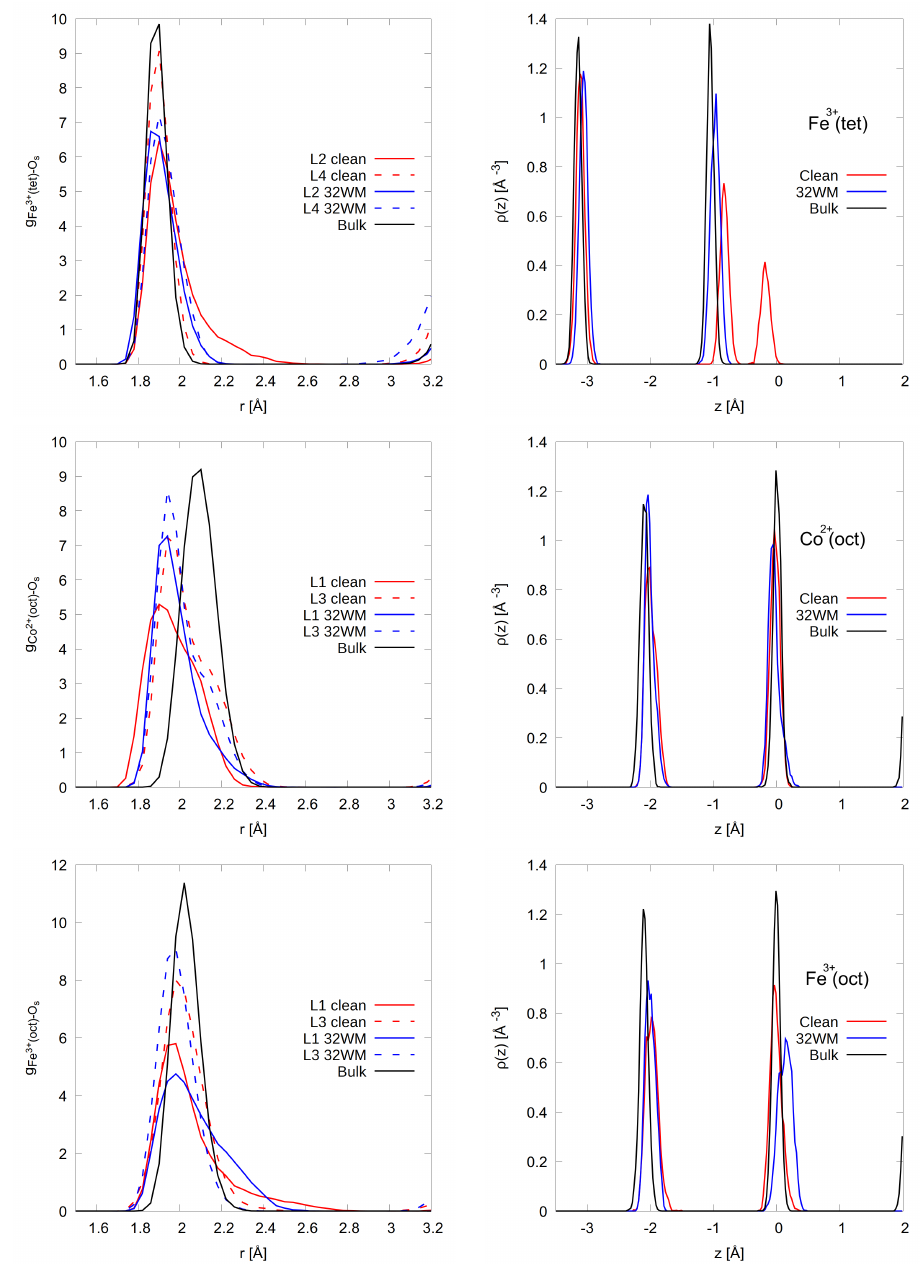
Figure 9. Radial distribution function ( left ) of the lattice oxygens to the cobalt and iron ions in the 4 layers outermost (L1–L4) and density profiles ( right ) of the latter on the B-terminated surface. The center of mass of layer L1 (see Figure 1) is taken as reference position z =